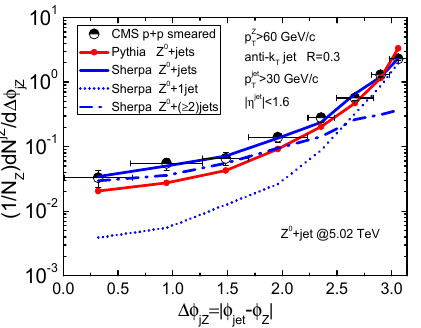
Figure 7. The azimuthal angle correlations ∆ φ jZ in p + p collisions at 5.02 TeV with the NLO + PS simulations by Sherpa, and LO + PS simulations by Pythia [16]. Experimental data are from CMS measurement [35].